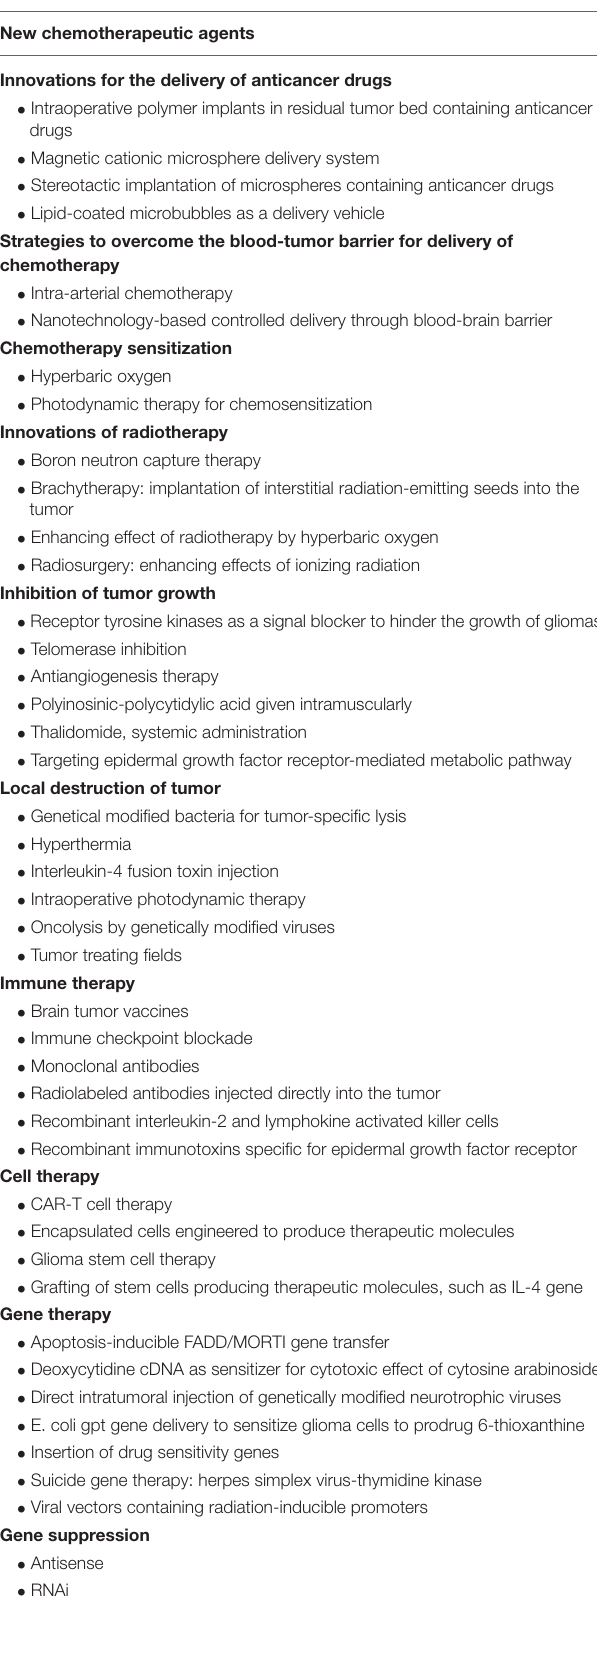
TABLE 1 | Innovative therapies for